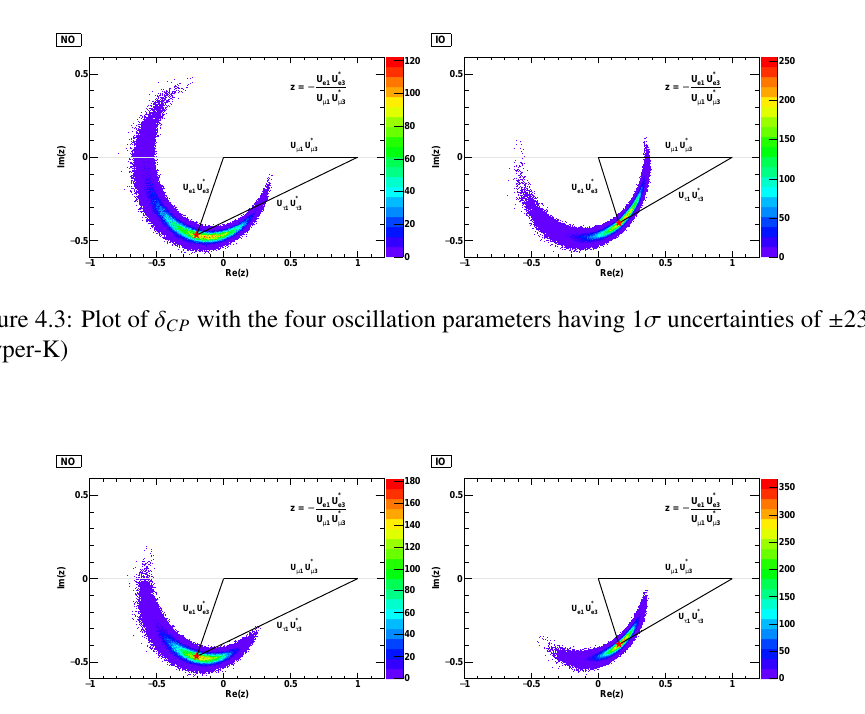
Figure 4.4: Plot of δ CP with the four oscillation parameters having with 1 σ uncertainties of ± 15 o . (Combining Hyper-K and